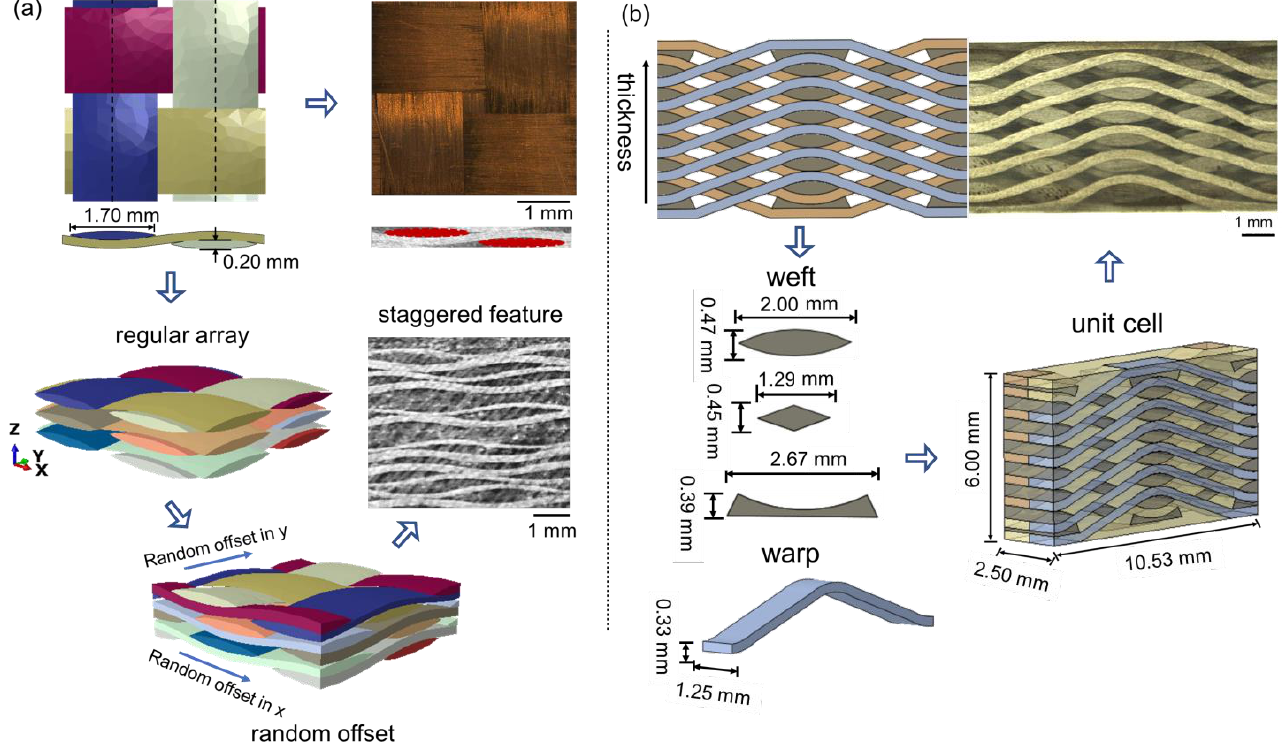
Figure 2. Mesoscale geometry models: ( a ) 2-D PWC; ( b ) 2.5-D AWC. Linear tetrahedral elements (C3D4) were chosen to generate the mesh of the yarns and matrix for both PWC (Figure 3a) and AWC (Figure 3b) models. Zero-thickness